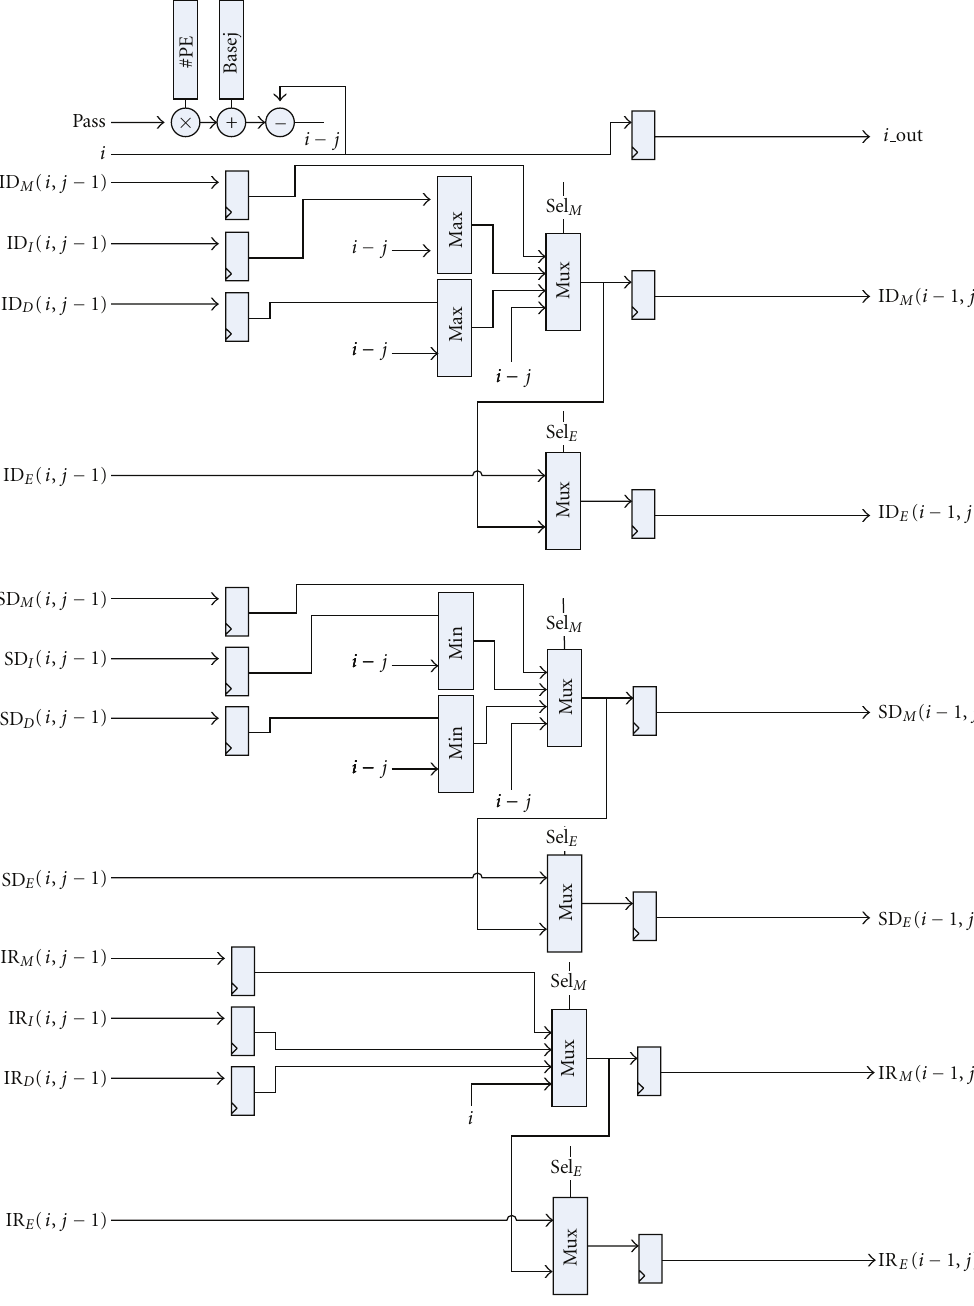
Figure 9: Divergence calculating stage for M and E